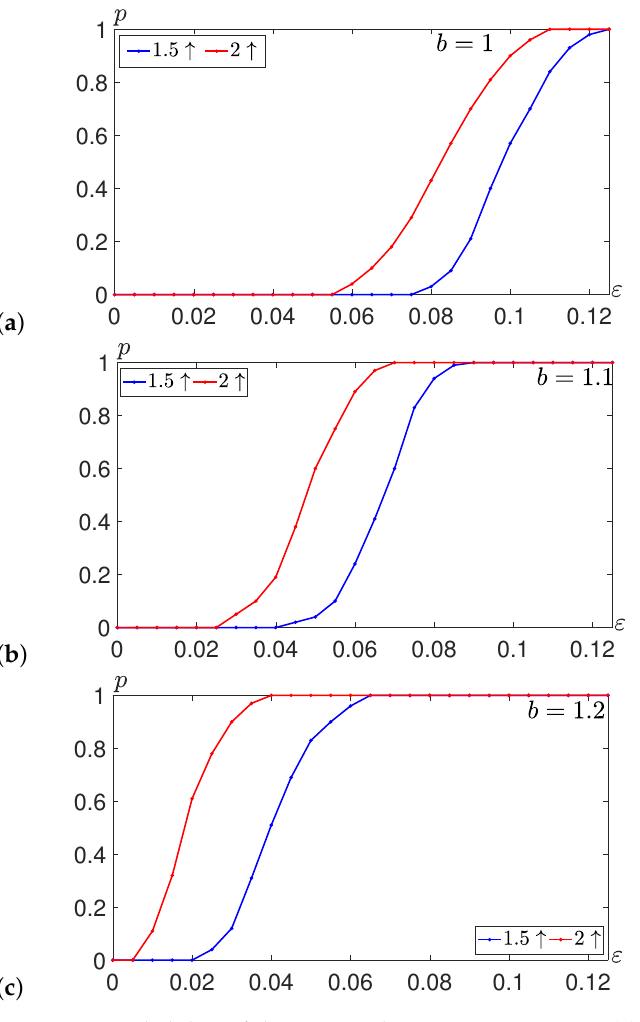
Figure 12. Probability of the pattern destruction in Systems (1), (2) with a = d = e = 0.5, c = 1, D u = 5 × 10 − 4 , D v = 0.02 versus the noise intensity ε for ( a ) b = 1, ( b ) b = 1.1, ( c ) b = 1.2.